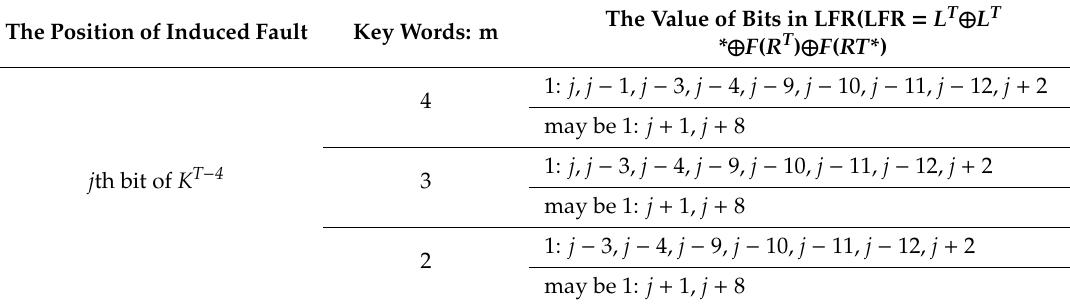
Table 3. The j th bit of K T − 4 a ff ects the bits of